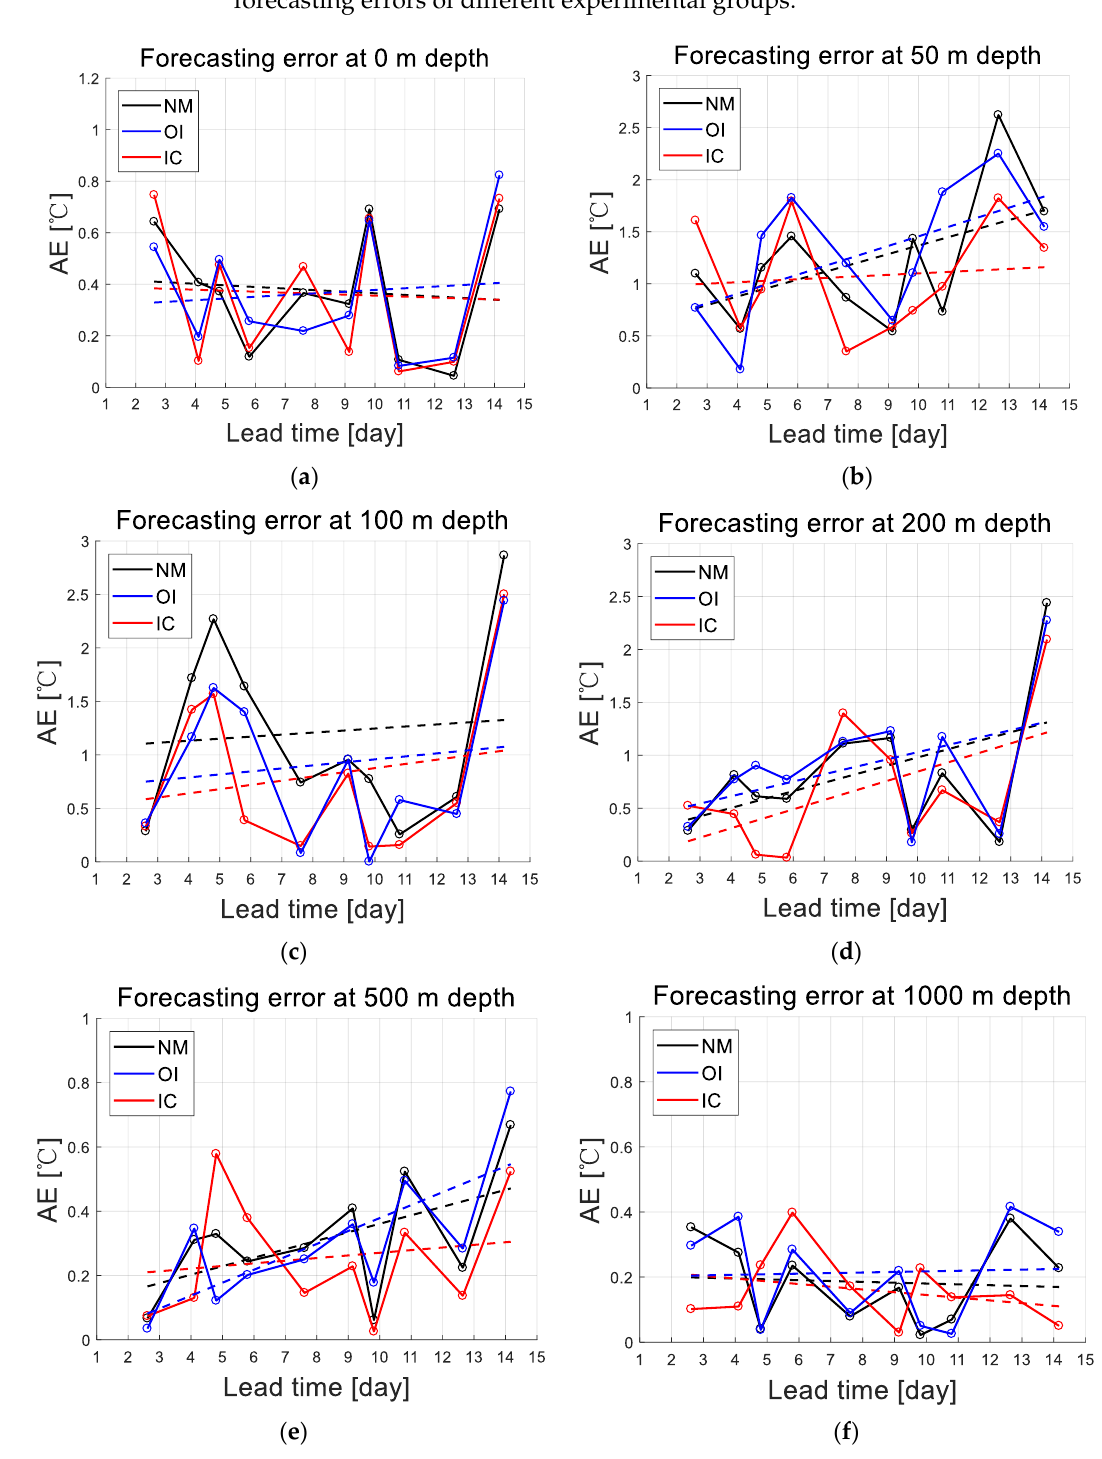
Figure 5. Temperature forecasting error of Experiment 1. ( a ) 0 m; ( b ) 50 m; ( c ) 100 m; ( d ) 200 m; ( e ) 500 m; ( f ) 1000 m. The black line is the forecasting error of the original numerical model (NM), the blue line is the forecasting error of the OI, the red line is the forecasting error of the IC and the dashed line is the error regression line.